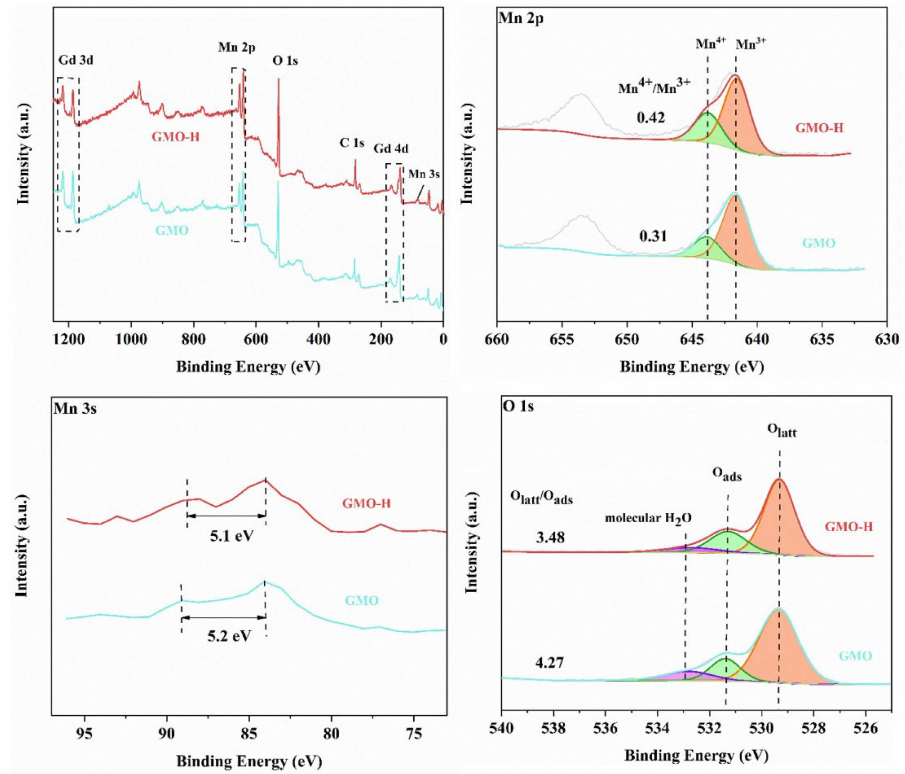
Figure 4. XPS spectra of GMO and